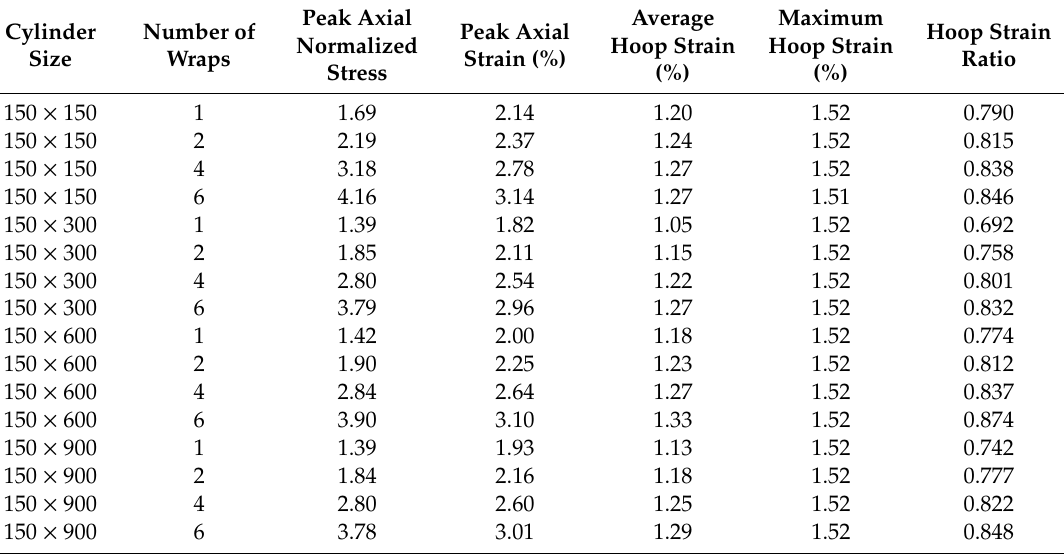
Table 1. Axial and hoop stresses and strains, and the strain